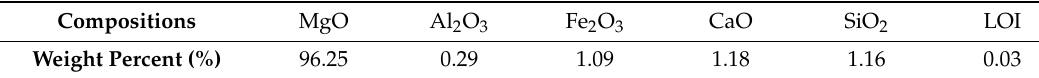
Table 2. Chemical compositions of MgO.